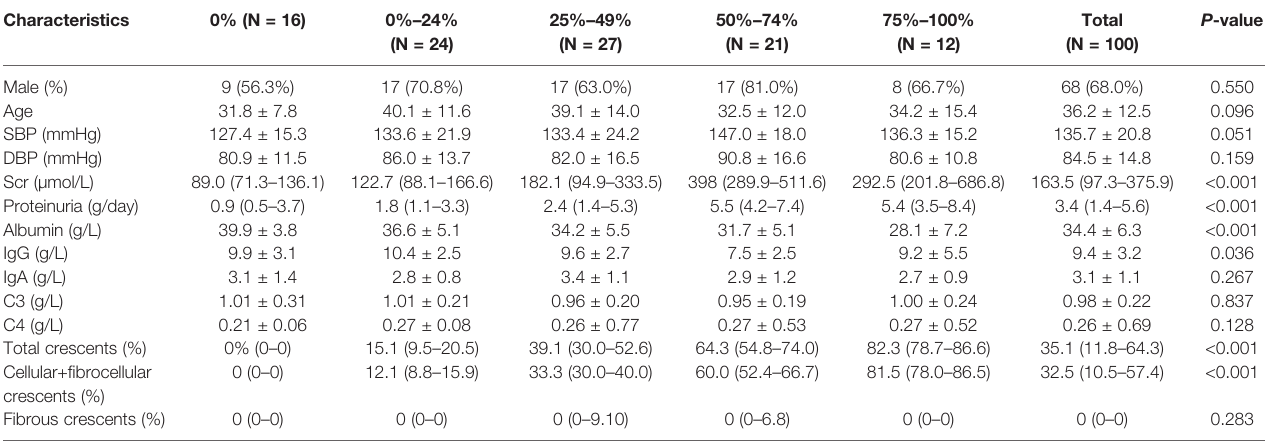
TABLE 1 | Baseline characteristics of IgAN patients with various crescents forming.